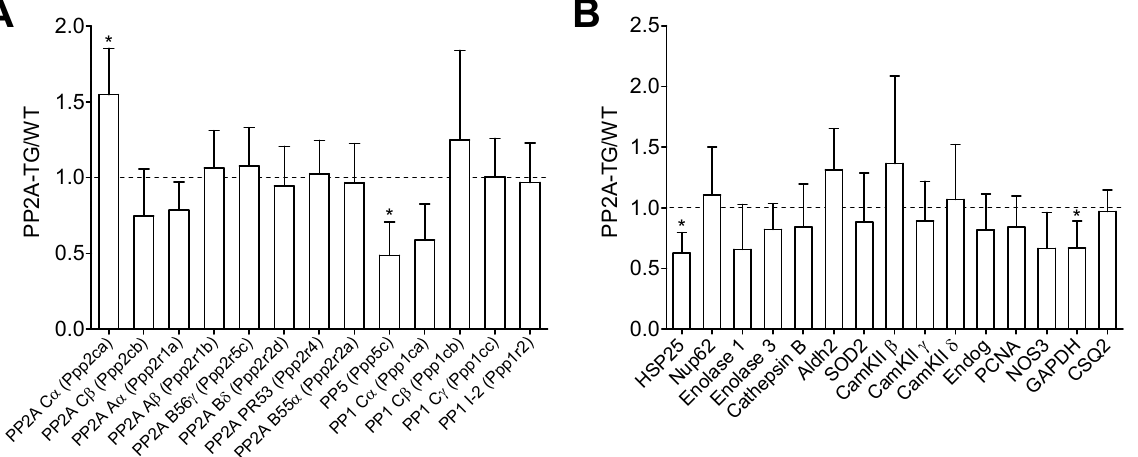
blots are presented in supplementary .